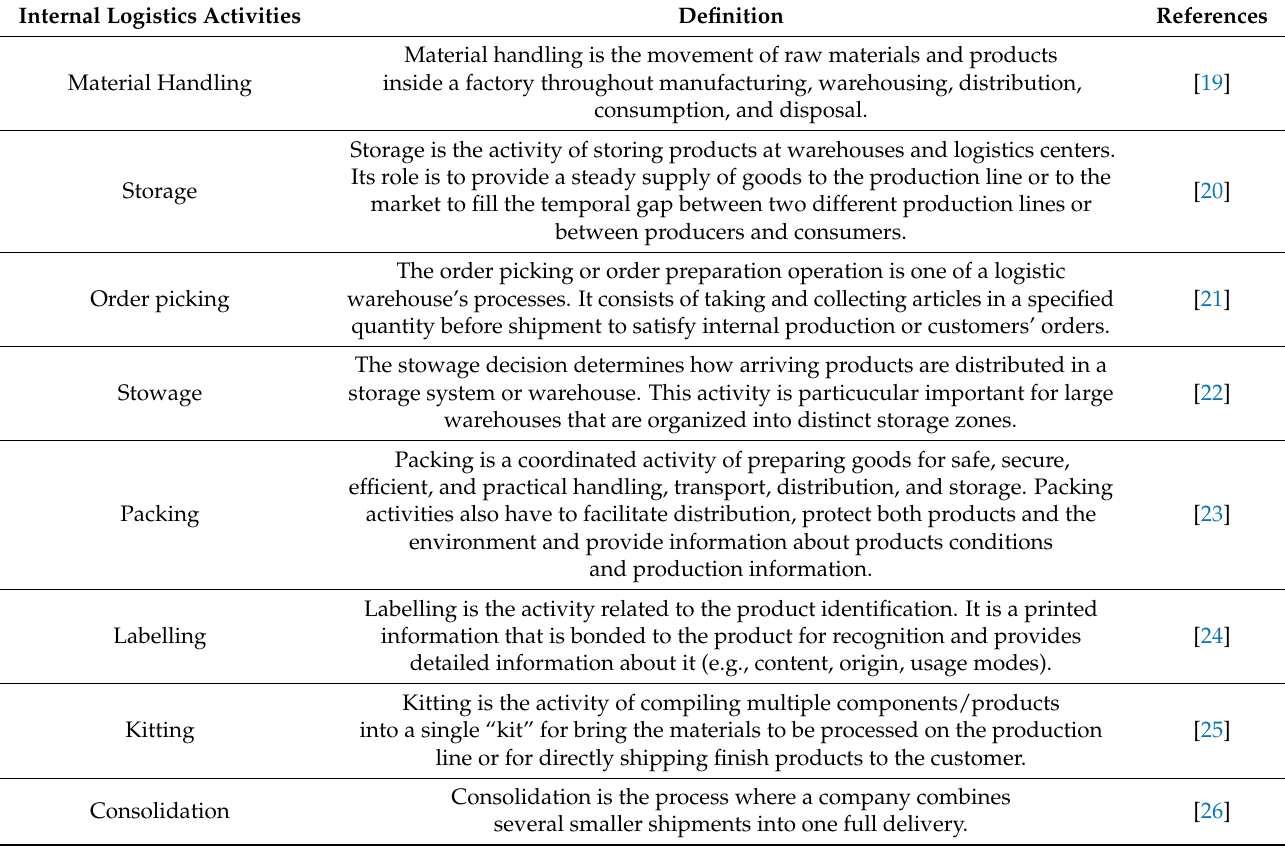
Table 1. Internal logistics